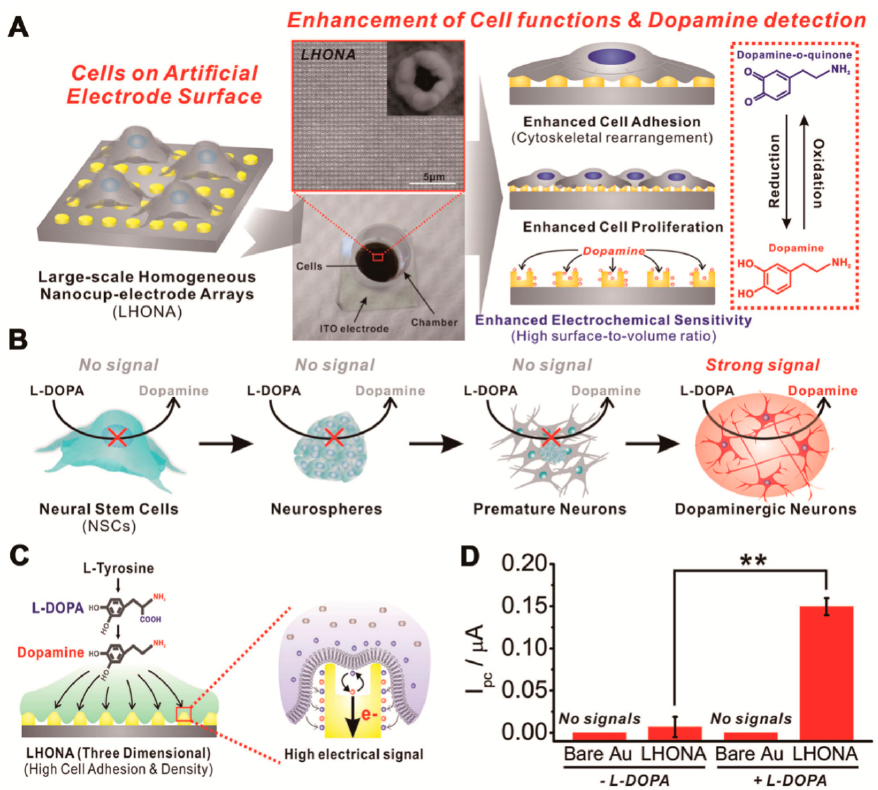
Figure 3. ( A ) Schematic diagram showing the superiority of large-scale homogeneous nanocup electrode arrays (LHONA) as a conductive cell culture platform that enhances major cell functions and electrochemical sensitivity with regard to dopamine detection; both are extremely important for cell-based sensors. The figure shows a cell-based chip used in the detection of dopamine released from the dopaminergic cells composed of the ITO electrode, LHONA, and cell culture chamber. The structure of LHONA as characterized by scanning electron microscopy is also shown in the above image. ( B ) Detection strategy to discriminate the dopaminergic neurons from other types of their progenitor cells by using L-DOPA pretreatment and LHONA as the cell culture platform (working electrode) based on the electrochemical method. Only the cells capable of converting L-DOPA to dopamine can provide distinct redox peaks that can be used as an indicator for the presence of dopaminergic neurons. ( C ) Schematic diagram showing the interaction between the cell membrane and surface of electrodes, which results in the increase of the model dopaminergic cells’ electrical signals in LHONA owing to enhanced cell spreading, adhesion, and proliferation. ( D ) The CV results of PC12 cells on bare Au and LHONA substrates. For LHONA with +L-DOPA and -L-DOPA, the Ipc values of dopamine were 0.222 µA and 0.022 µA, respectively. +L-DOPA means that the PC12 cells